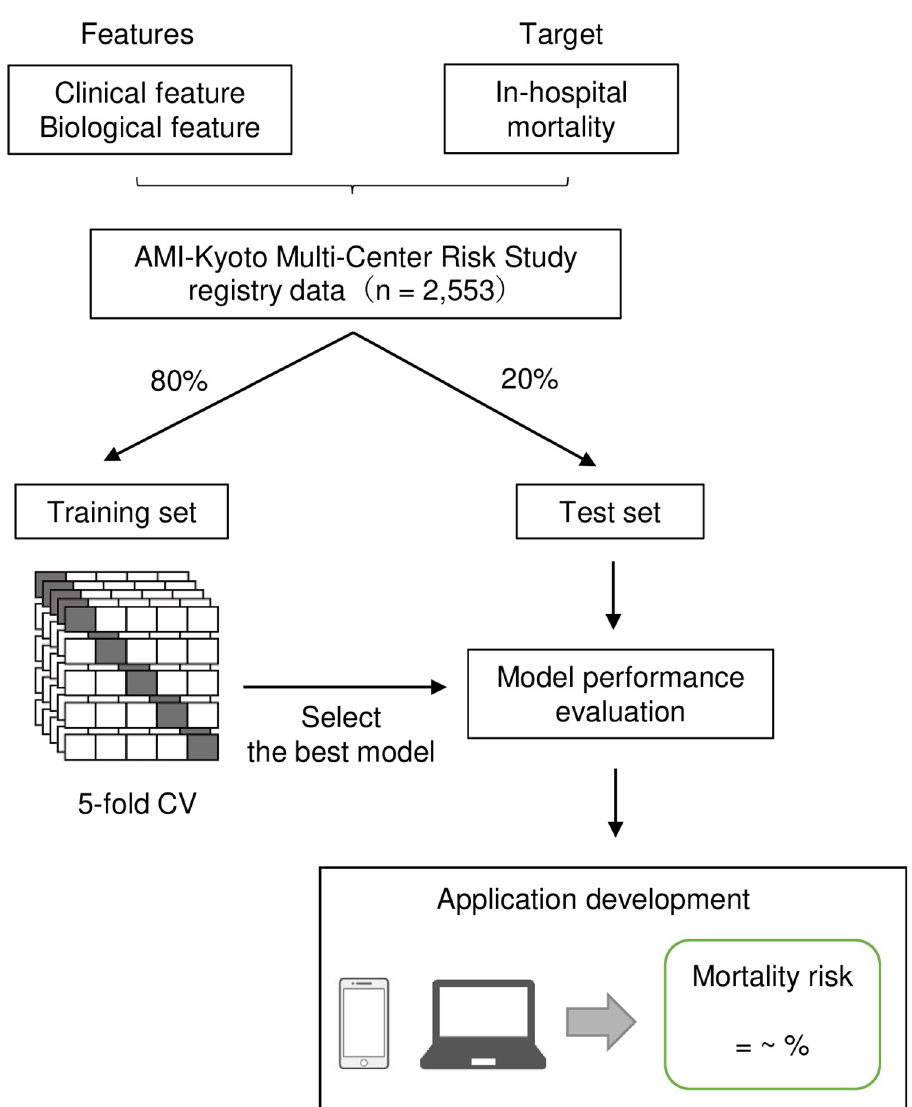
Fig 1. Overview of development of prognostic prediction model for acute myocardial infarction. A total of 2,553 cases were divided into training (80%) and test (20%) subsets. A random forest classifier was trained on several clinical and biological features on the training subset using 5-fold cross validation (CV) to predict in-hospital mortality in patients with ST-elevation acute myocardial infarction (STEMI). The resulting trained model with the best hyperparameters was evaluated using various performance metrics using the test subset. The online application tool to predict in-hospital mortality risk in patients with STEMI was developed according to the programming code of the